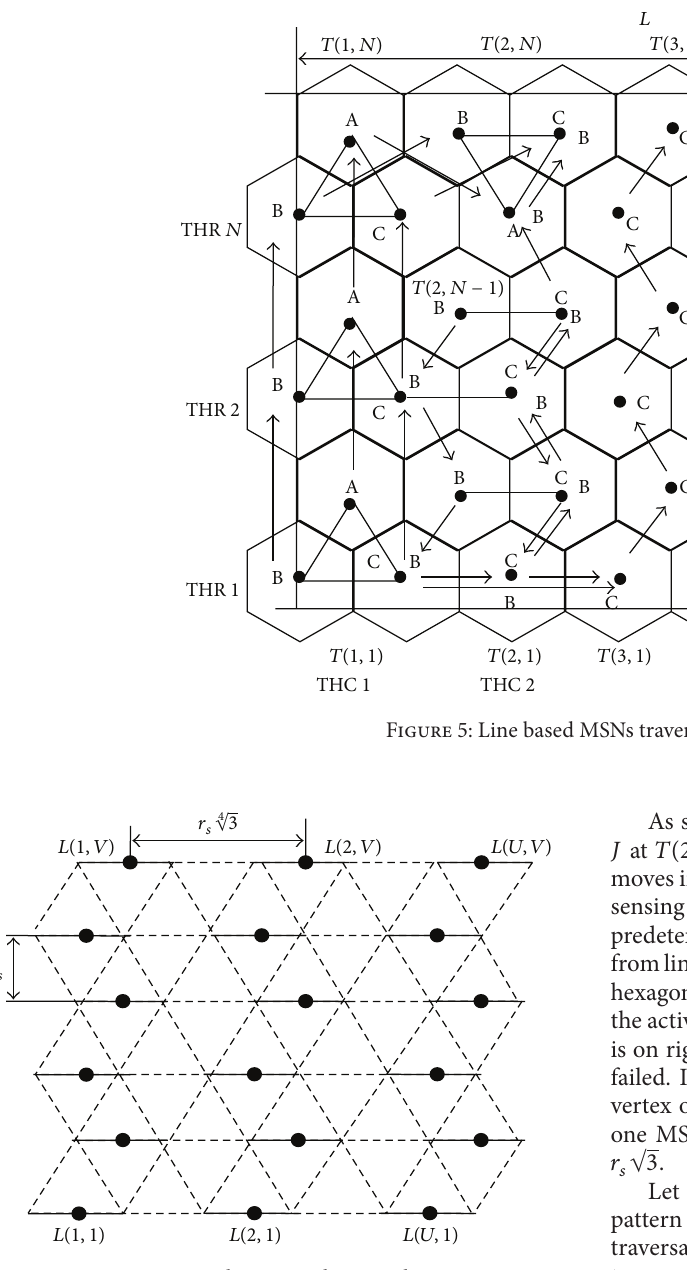
Figure 6: Hamiltonian path in graph 𝐺 𝑆